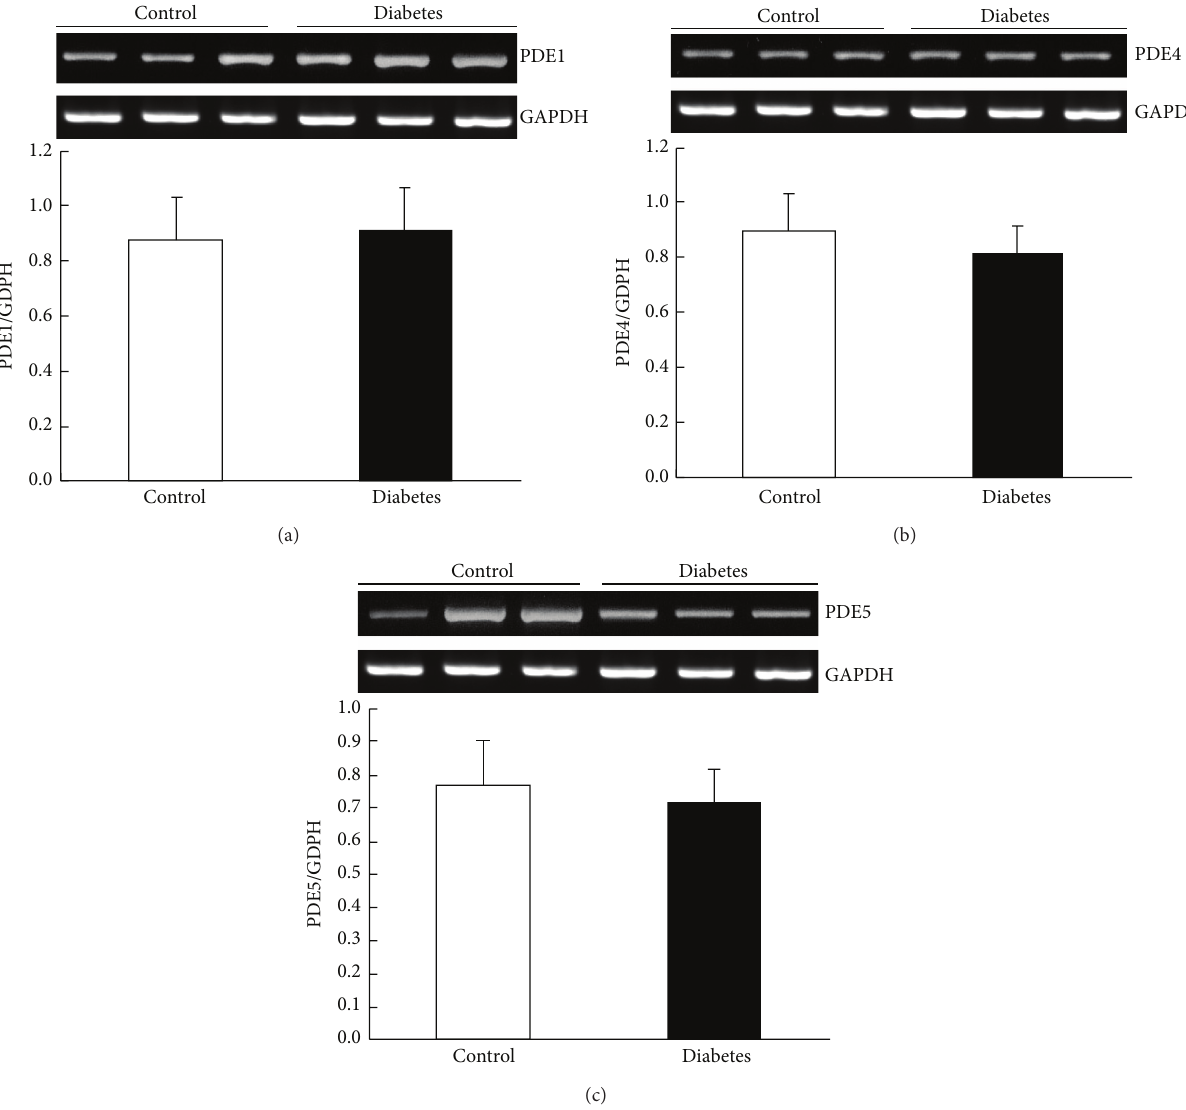
Figure 5: Expression of other PDEs in the gastric smooth muscle. (a) The mRNA level of PDE1 in the gastric smooth muscle was not different between the diabetic rats and controls ( 𝑛 = 9 , 𝑃 > 0.05 ). (b) The mRNA level of PDE4 in the gastric smooth muscle was not different between diabetic rats and controls ( 𝑛 = 9 , 𝑃 > 0.05 ). (c) The mRNA level of PDE5 in the gastric smooth muscle was not different between diabetic rats and controls ( 𝑛 = 9 , 𝑃 > 0.05